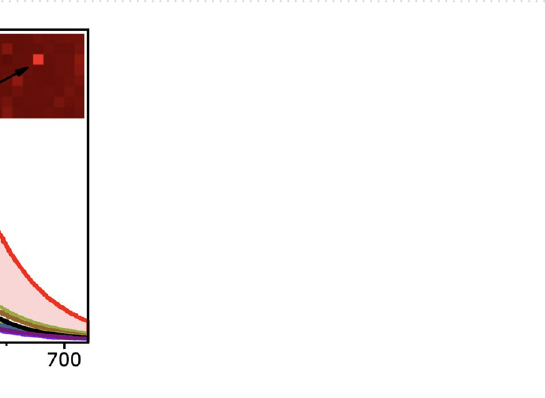
Figure 2. ( a ) Absorption spectra and photoluminescence (PL) spectra of InP/ZnS QDs film. The laser wavelength used is 532 nm (green vertical line). The highlighted red area corresponding to plasmon resonance peak of the Au NPs. ( b ) Reflectivity of thick layer SiO 2 . ( c , d ) SEM images of Al pattern and Au NPs on top of Al using the dropcast method, inset showing high-resolution SEM image. ( e , f ) 3D AFM images of the QDs without (control) and with Au NPs on top of the Al nanostructure sample taken at location from samples A ( e ) and B ( f ).